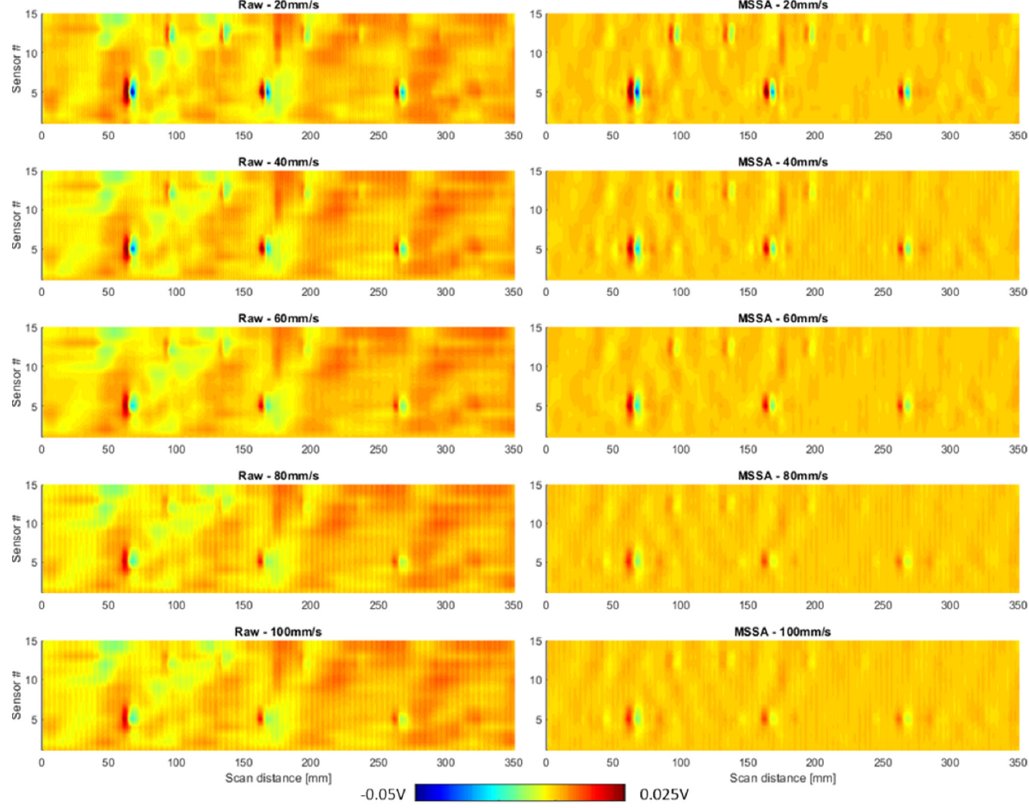
Figure 13. Raw magnetic scanned signal with mean subtraction and the proposed MSSA filter at different speed of 20, 40, 60, 80 and 100 mm/s.